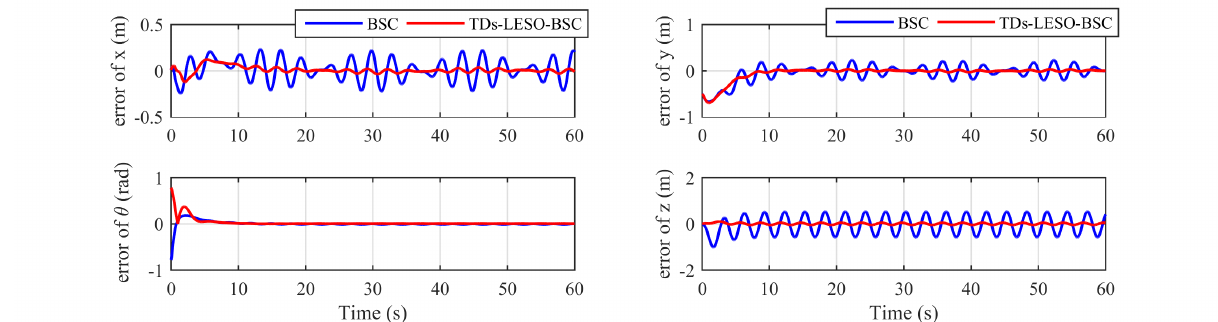
Figure 15. The comparison of different controllers for tracking a spiral trajectory with serious disturbances.